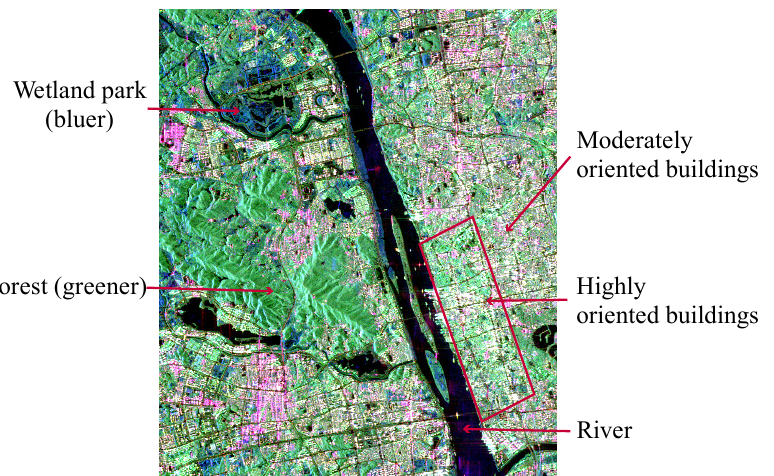
Figure 2. The color-coded image of Pauli decomposition of the ALOS-2/PALSAR-2 dataset (red: | S HH − S VV | 2 /2, green: 2 | S HV | 2 , blue: | S HH + S VV | 2